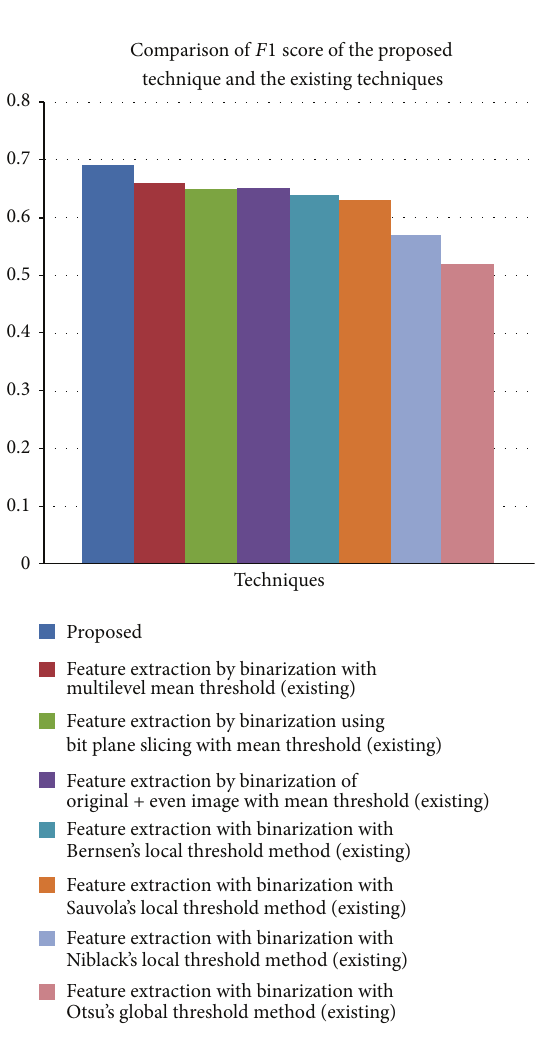
Figure 11: Comparison of 𝐹1 score of the proposed technique with respect to the existing